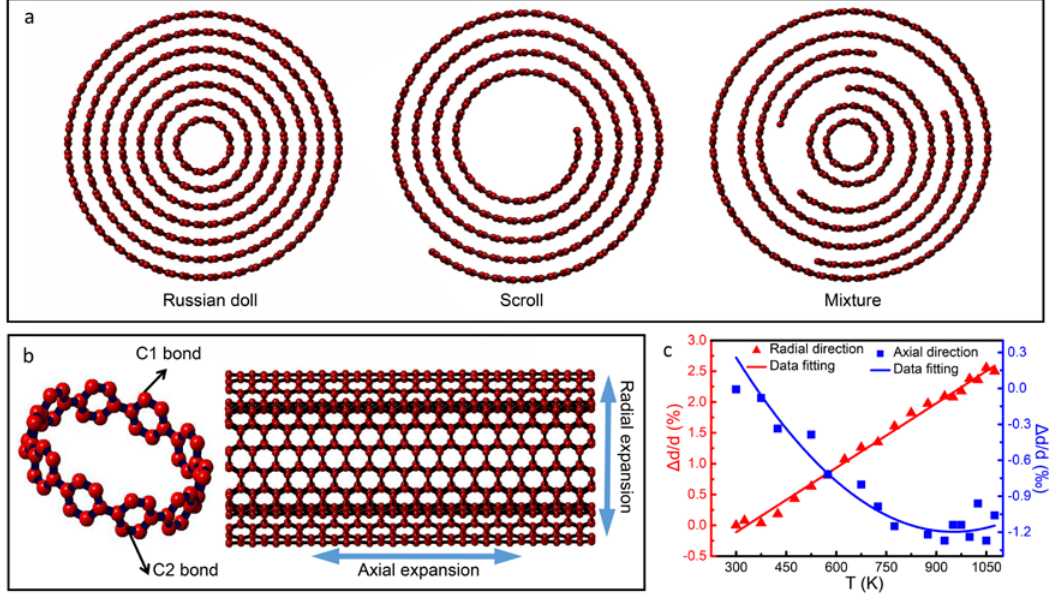
Figure 1. Atomic models for tubular structure, the radial and axial directions are indicated. ( a ) Three types of BN tubular structure: Russian doll, scroll and the mixture; ( b ) Lattice change in the radial and axial directions in nanotubes of Russian doll; ( c ) Thermal coefficient of multi-walled boron nitride nanotubes using the in situ TEM heating experiment.